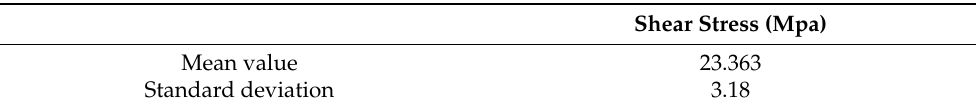
Table 7. Results of shear stress for all samples (the complete set of results are available in the Appendix A in Table A5).